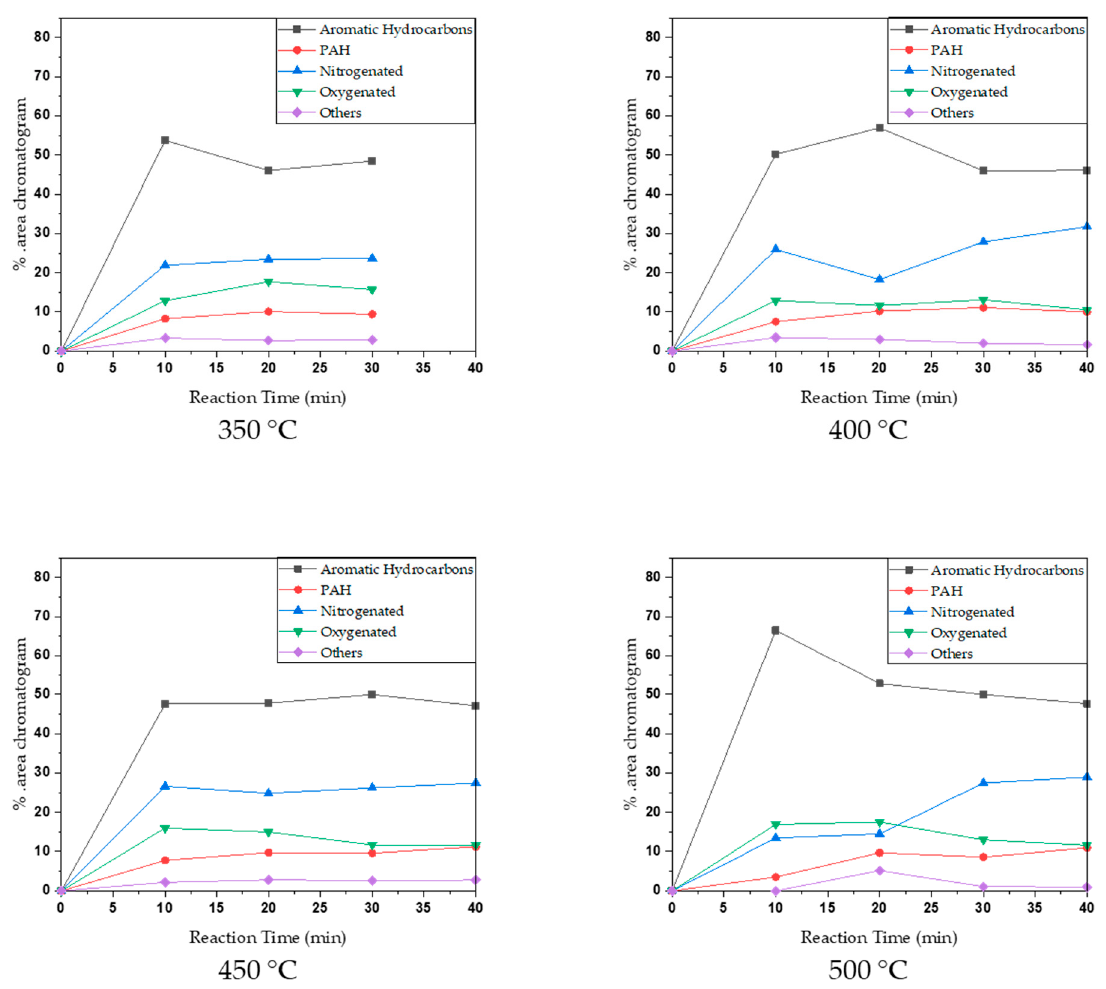
Figure 14. Time behavior of chemical functions present in thermal cracking of WEEE plastic at 350, 400, 450, and 500 °C.